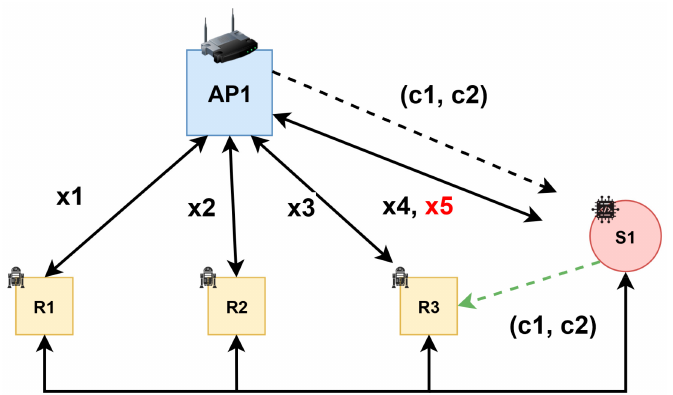
Figure 9. Group membership validation